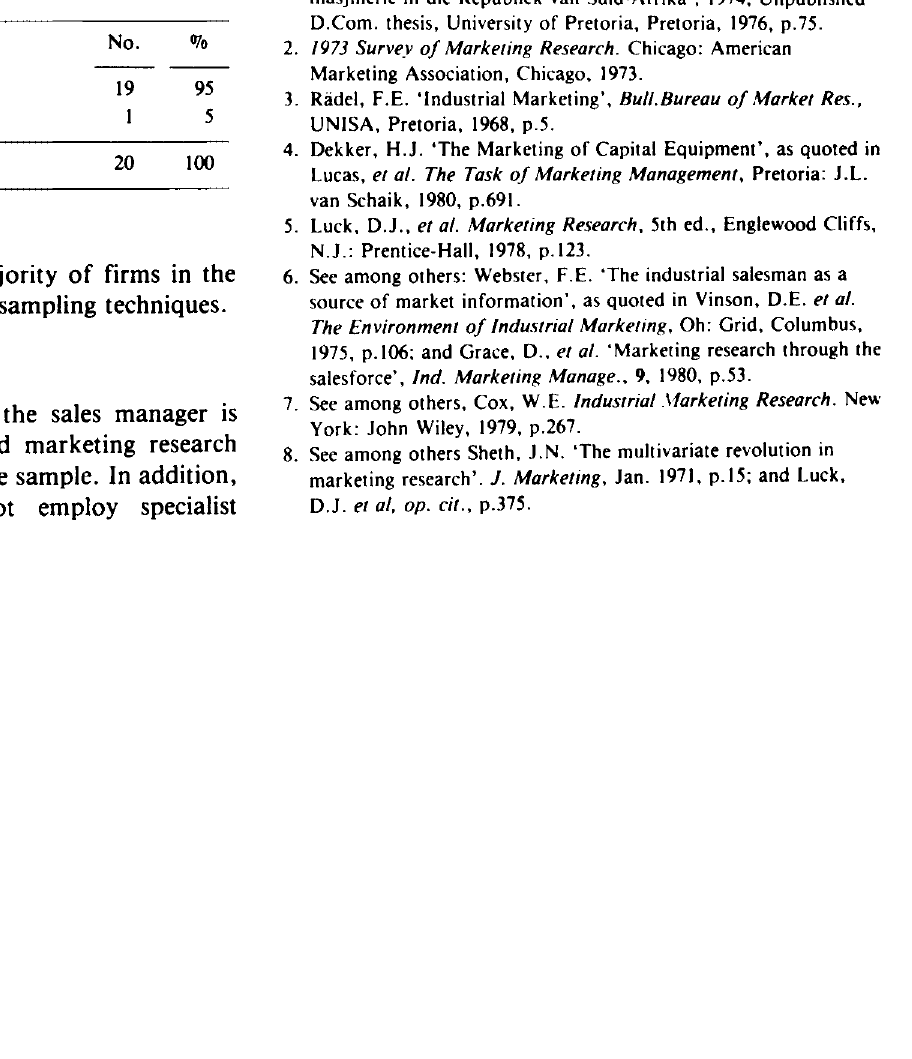
Types of sampling techniques used by in